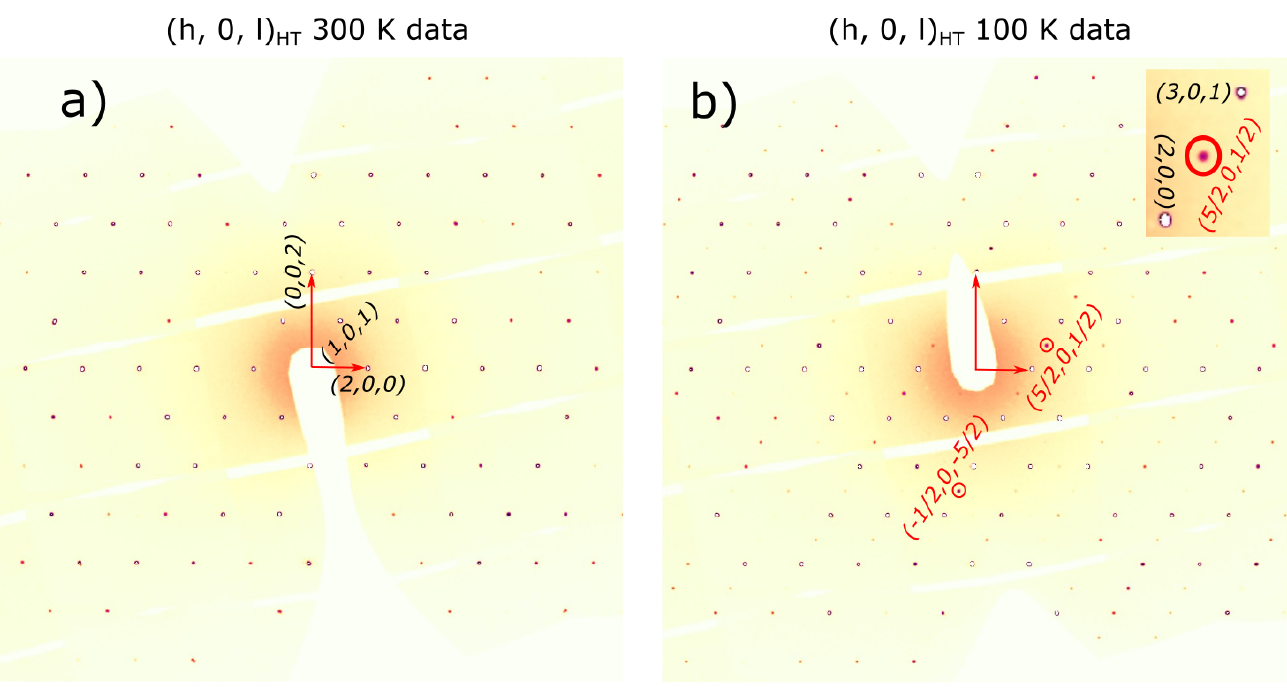
Figure 3. Neutron diffraction measurements collected on WISH instrument at the ISIS spallation neutron source; black open circles represent data collected on bank 3 (2 θ = 90 degrees) in panel ( a ) and bank 2 (2 θ = 58 degrees) in panel ( b ); red solid line represents the results of the Rietveld refinement; blue solid line represents the difference between the model and the experimental data; green vertical lines represent the position of the d spacings corresponding to crystallographic planes in the crystal model.